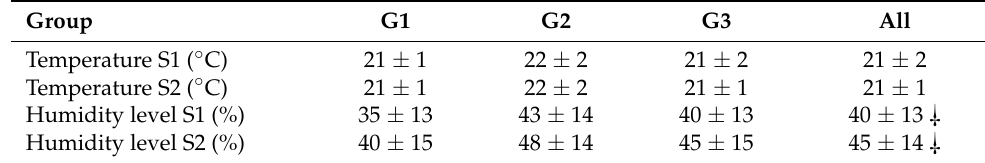
Table 2. Environmental conditions between sessions.